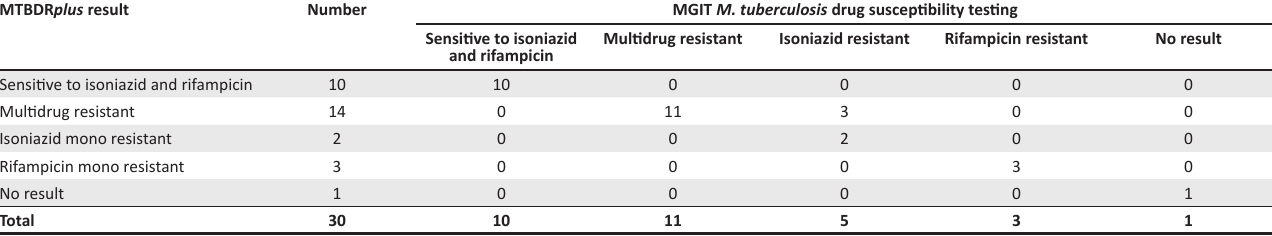
Abbreviations: MGIT, mycobacterium growth indicator TABLE 4: Comparison of MTBDR plus and mycobacterium growth indicator tube Mycobacterium tuberculosis drug susceptibility testing. MTBDR plus result